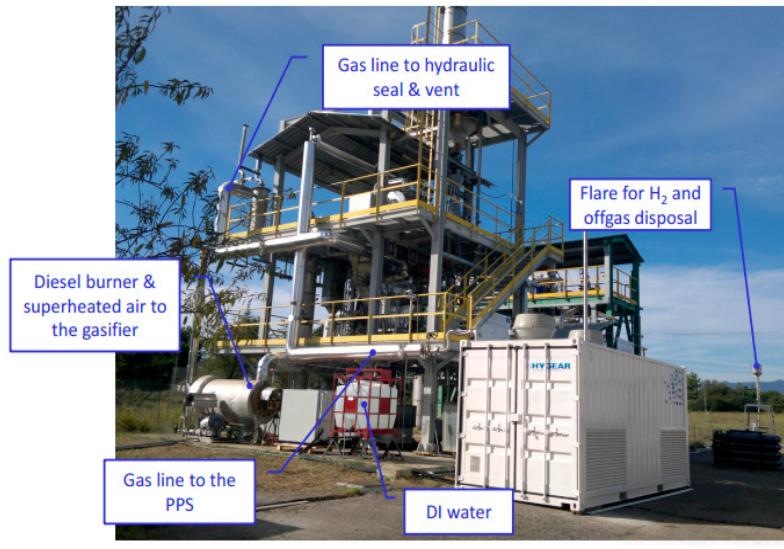
Figure 2. A picture of the plant.